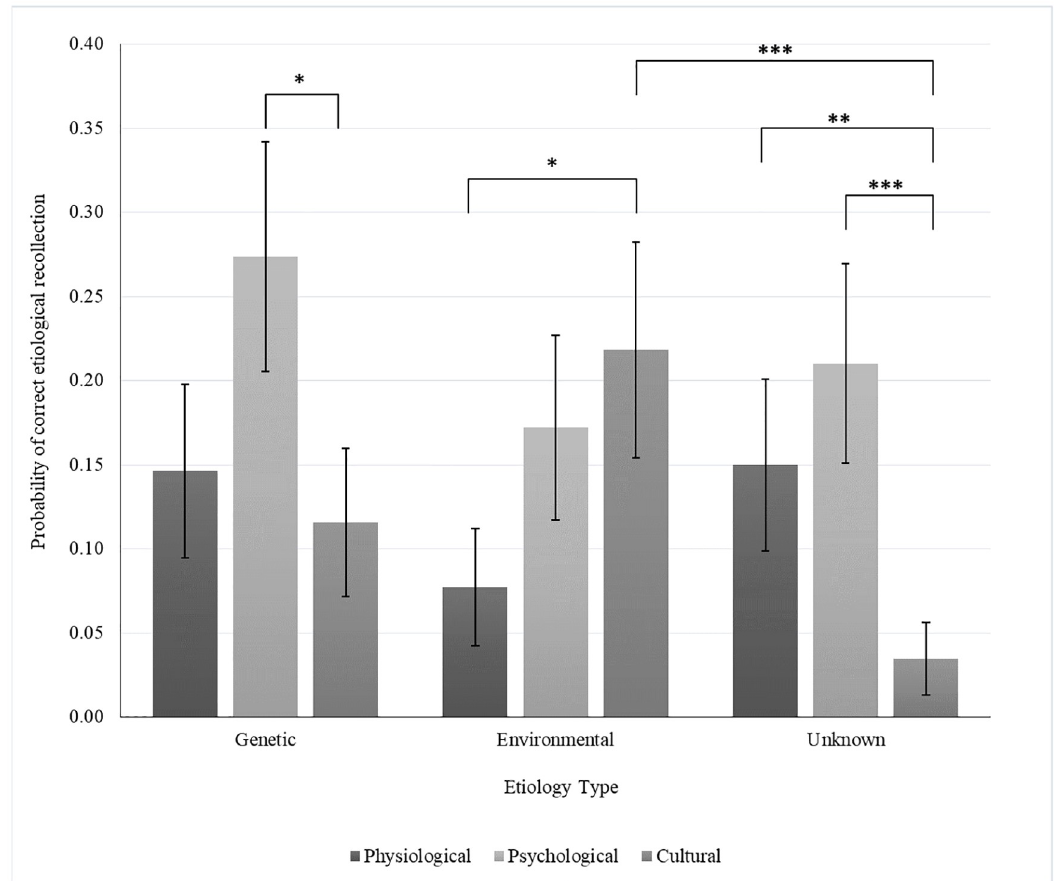
Fig 1. Two-way interaction of Etiology Type and Disorder Type on probability of correct etiological recollections (with SE mean ). Note : ��� p < .005; �� p < .030; � p < .050. https://doi.org/10.1371/journal.pone.0218703.g001 outcome, the model was tested using a log-normal distribution. Lower scores are indicative of more desired social distance. The model showed that the main effect of Disorder Type was sig- nificant, F (2,367) = 106.33, p < .001 (see Fig 3). Contrasts showed that participants were most comfortable with their sibling dating a patient diagnosed with the Physiological Disorder ( M = 4.89, SE = .12) compared to the Psychological ( M = 3.35, SE = .12), t (367) = 9.12, Table 3. Simple effects table at Etiology Type level for the probability of correct etiological recollections.